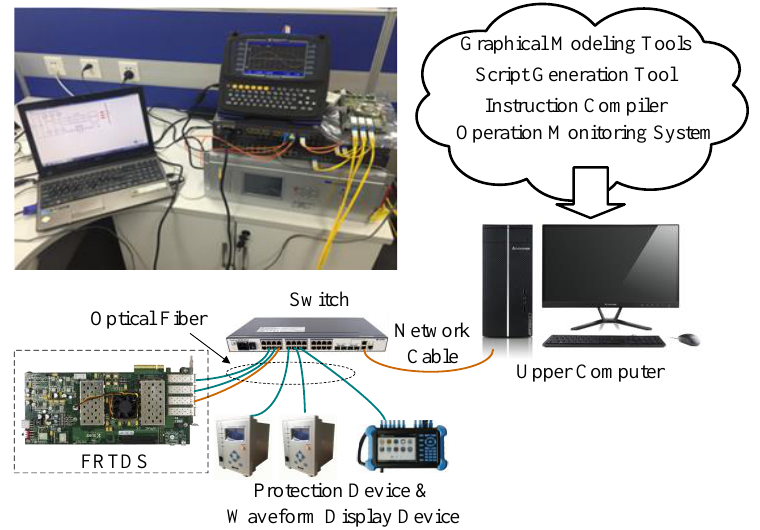
Figure 1. Schematic diagram and photo of hardware-in-the-loop system based on